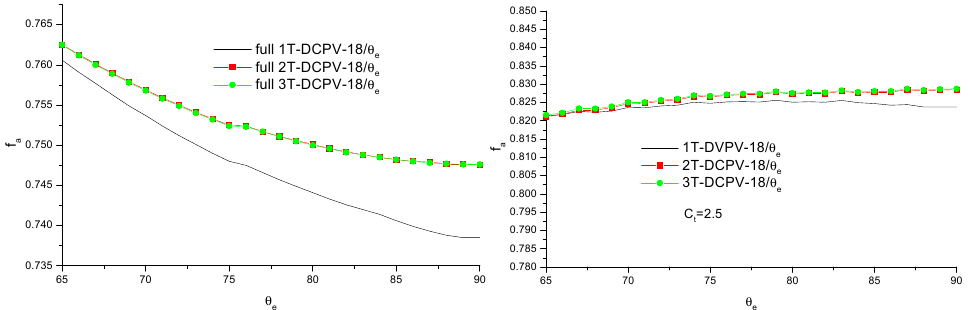
Figure 22 . Effects of tilt-angle adjustment strategy on the average annual optical efficiency of DCPV- θ 18/ e .